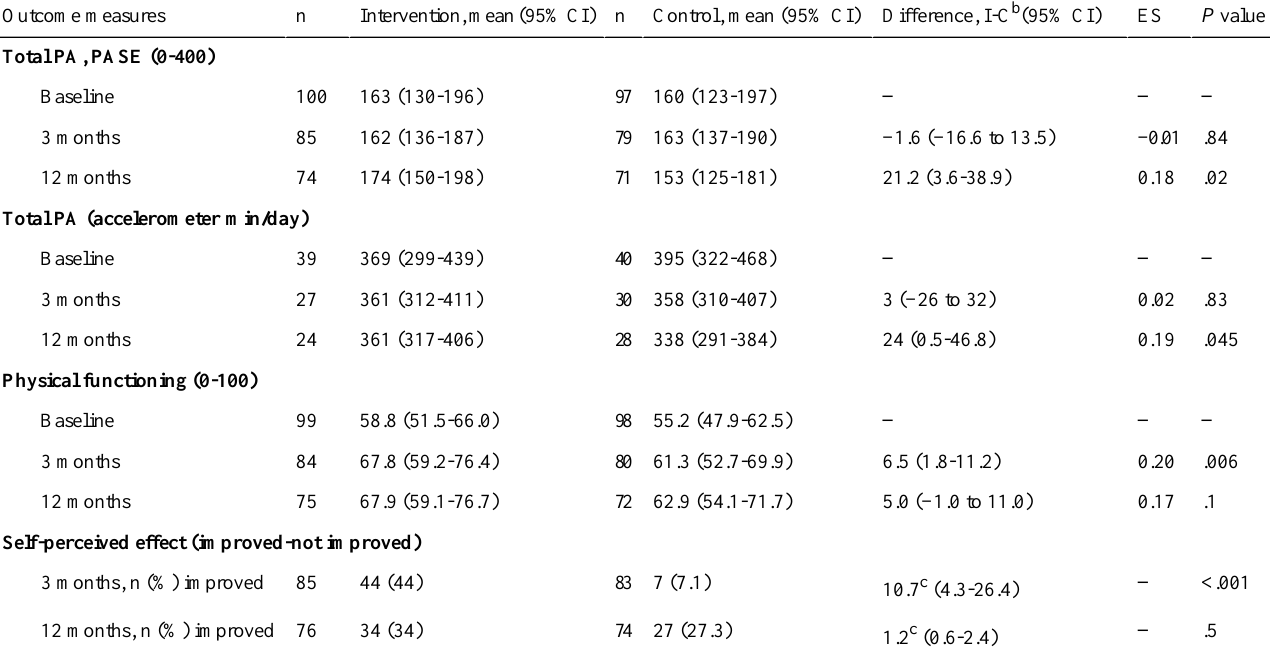
Table 2. Primary outcome measures: improvements and differences between groups a